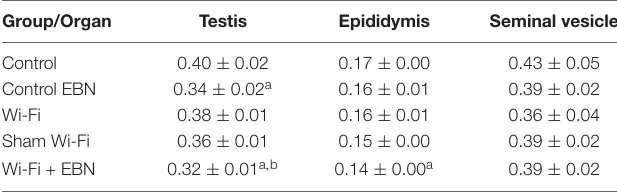
TABLE 3 | Organ coefficient of testis, epididymis and seminal vesicle in each